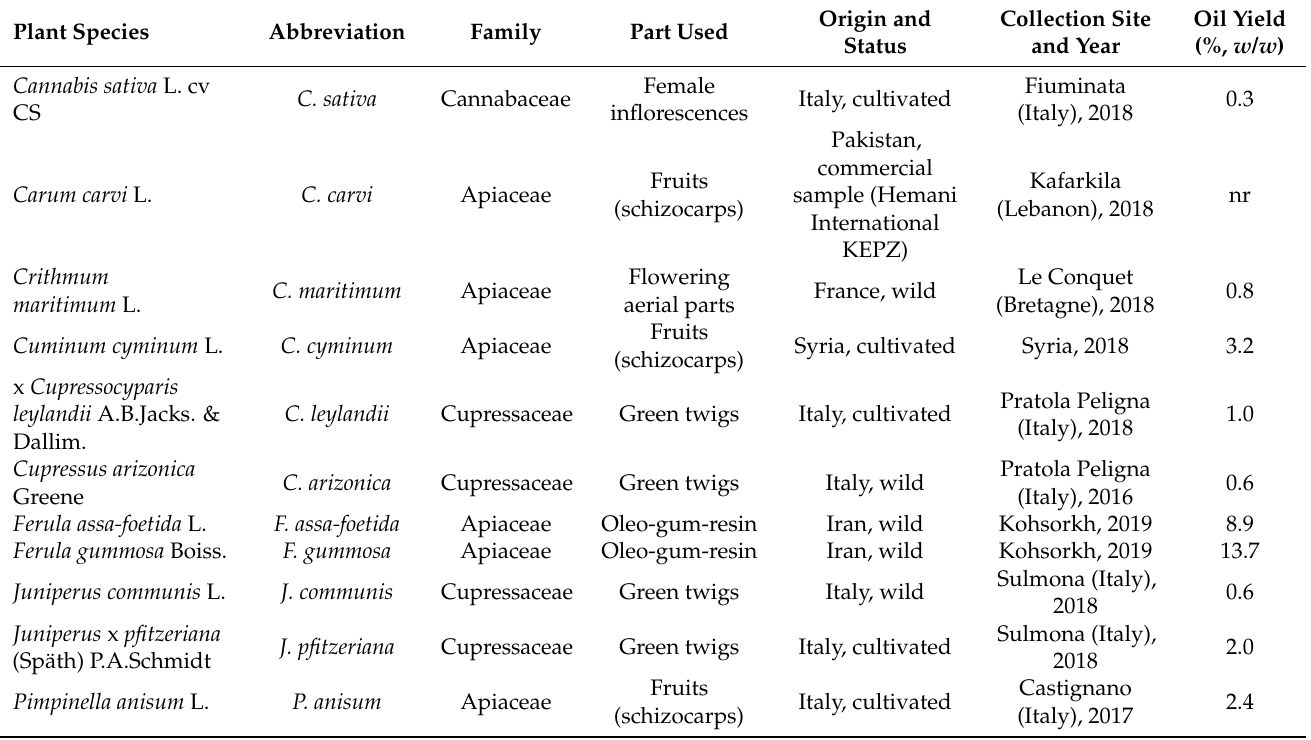
Table 4. Plant sources of the essential oils investigated in this